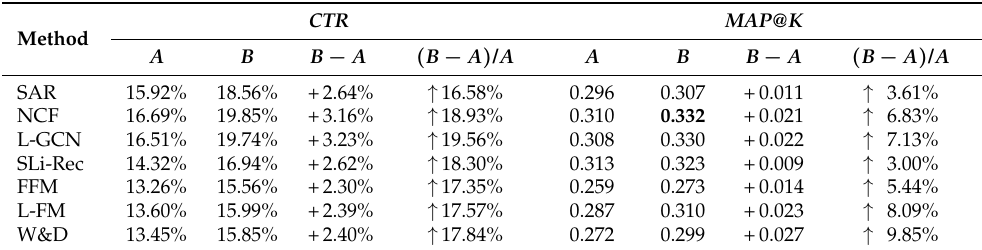
Table 6. The results of A/B experiments for the aggregation of information on the Yahoo